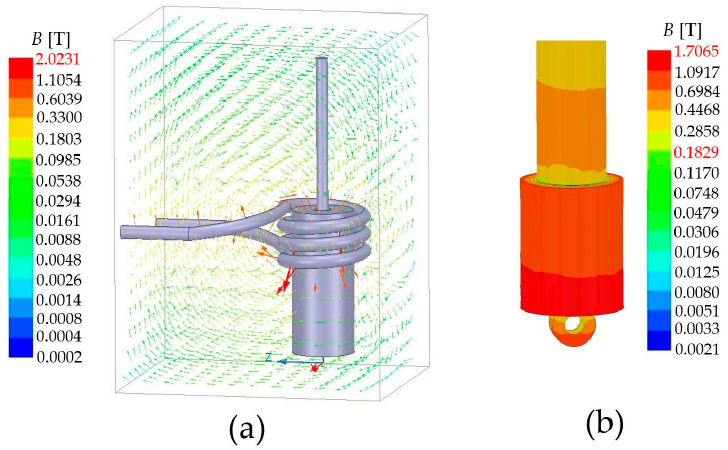
Figure 14. The magnetic flux density ( B ) with N = 3 for ( a ) an overview and ( b ) around the product.